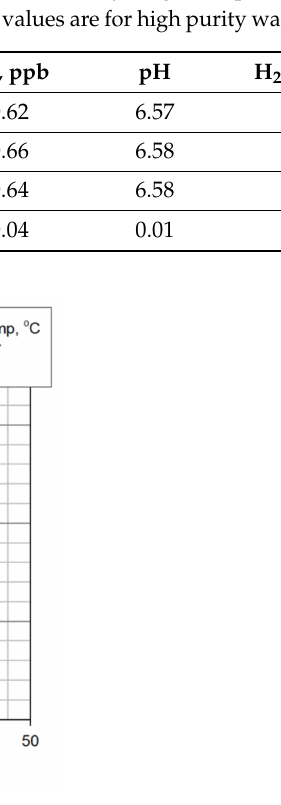
Table 2. Stability of water chemistry values (base levels for dissolved H 2 and flow rate were arbitrary, target temperature